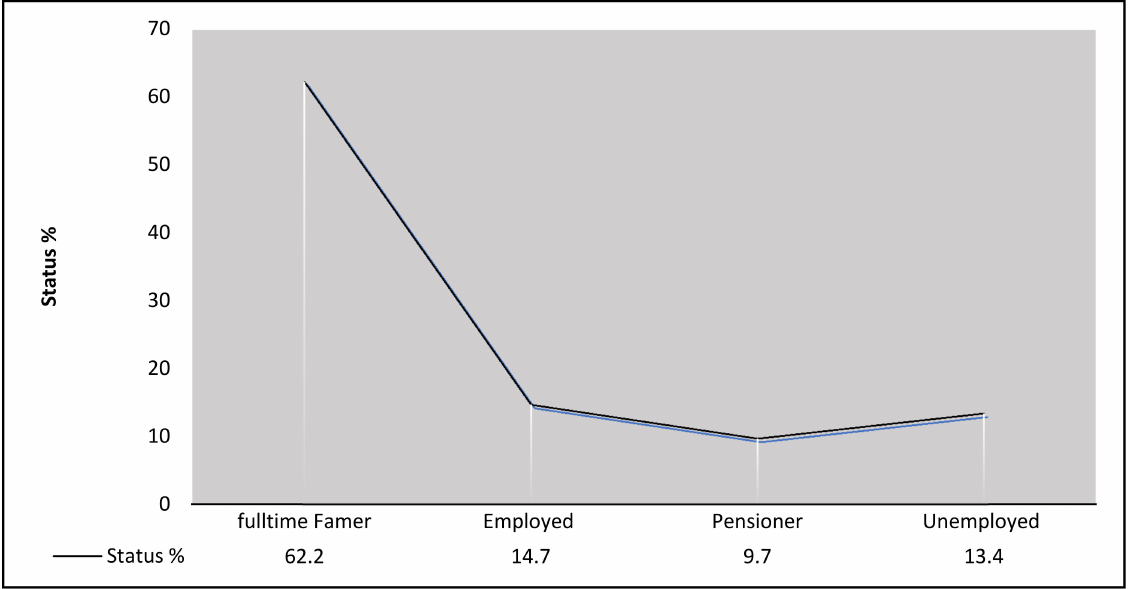
Figure 8. Employment status of household